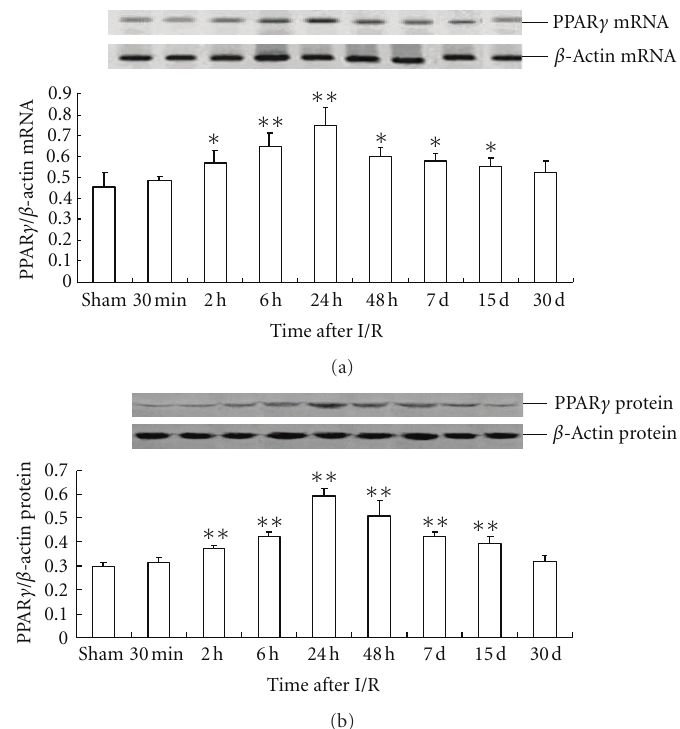
Figure 6: Time-dependent expression of PPAR γ in global cerebral I/R rat hippocampus( n = 4). (a) The relative mRNA level of PPAR γ was normalized to endogenous β -actin mRNA for each sample. (b) The relative protein level of PPAR γ was normalized to endogenous β -actin protein for each sample. Dates are expressed as mean ± SD of four individual experiments. ∗∗ P < 0 . 01 compared with sham group; ∗ P < 0 . 05 compared with sham